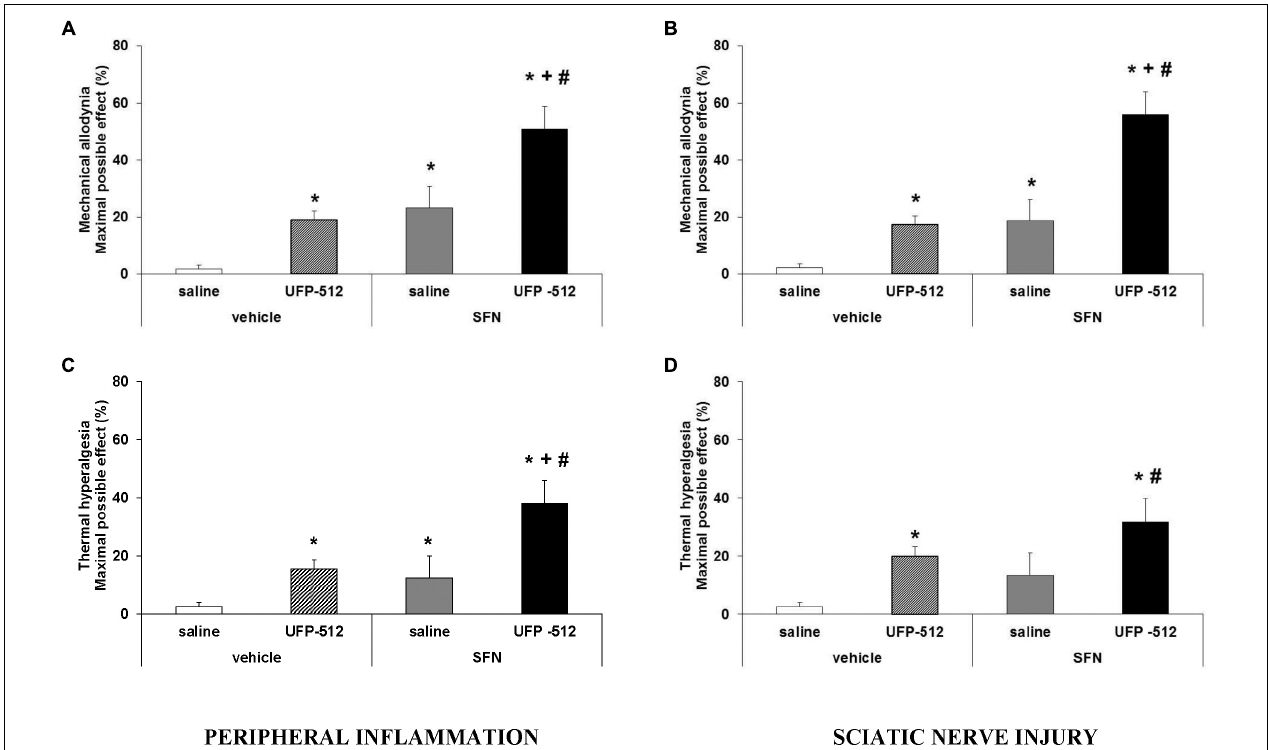
FIGURE 8 | Effects of the coadministration of UFP-512 with SFN on the mechanical allodynia and thermal hyperalgesia induced by peripheral inflammation or sciatic nerve injury. Mechanical antiallodynic and thermal antihyperalgesic effects produced by 10 mg/kg SFN and 1 mg/kg UFP-512 intraperitoneally administered alone or combined in animals with inflammatory (A, C) or neuropathic pain (B, D) are shown. SFN and UFP-512 were administered at 3 and 1 h before testing, respectively. For each test, ∗ indicates significant differences vs. its respective animals treated with vehicle plus saline, + indicates significant differences vs. its respective animals treated with vehicle plus UFP-512, and # indicates significant differences vs. its respective animals treated with SFN plus saline ( P < 0.05, one-way ANOVA, followed by the Student–Newman–Keuls test). Data are expressed as mean values of maximal possible effect (%) for mechanical allodynia and thermal hyperalgesia ± SEM; n = 6 animals per